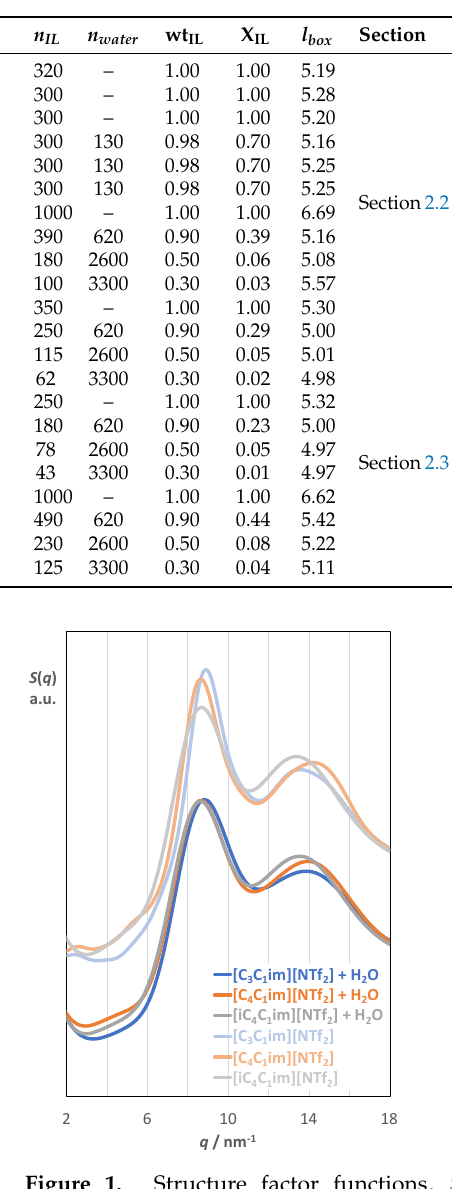
Table 1. Details of the molecular dynamics simulations performed for the water–ionic liquid mixtures and the corresponding sections where the systems are discussed. The final box length at 300 or 320 K is represented by l box (in nm); the number of IL pairs and water molecules are, respectively, n IL and n water ; the IL weight fraction is represented by wt IL ; and the IL mole fraction is denoted as X IL .